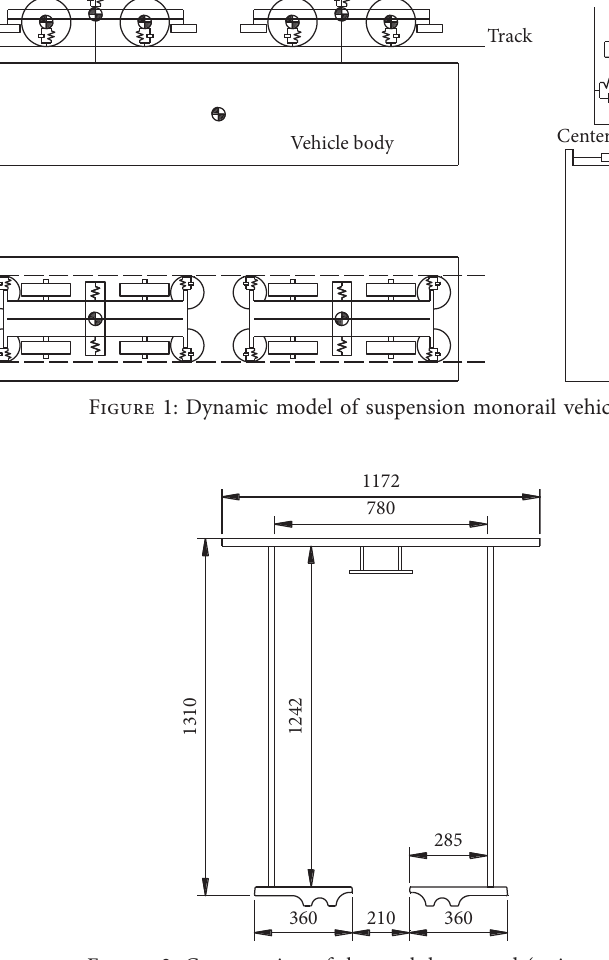
Figure 2: Cross section of the track beam end (unit: mm).